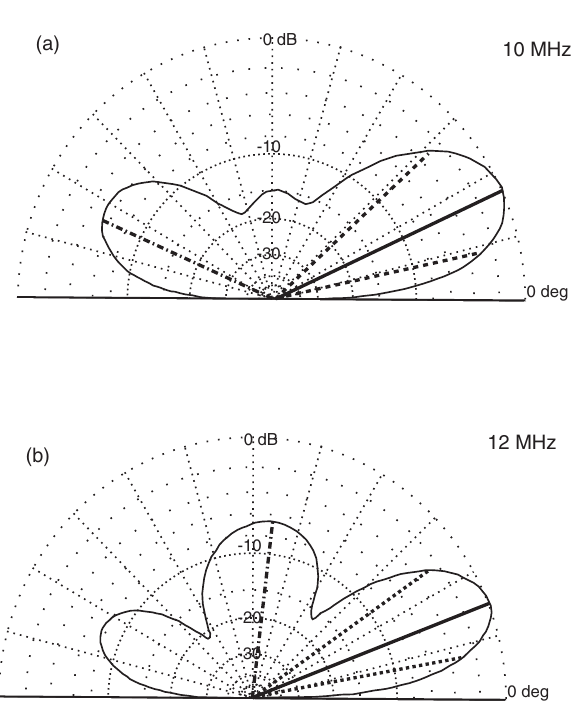
Fig. 1. SuperDARN Gain-Elevation plots for (a) 10MHz and (b) 12MHz (transmit only). The maximum sensitivities are at 26 and 22 degrees, respectively, and are denoted by thick solid lines. The angles of the 3db gain reductions are denoted by dashed lines and the largest side lobe by a dashed – dotted